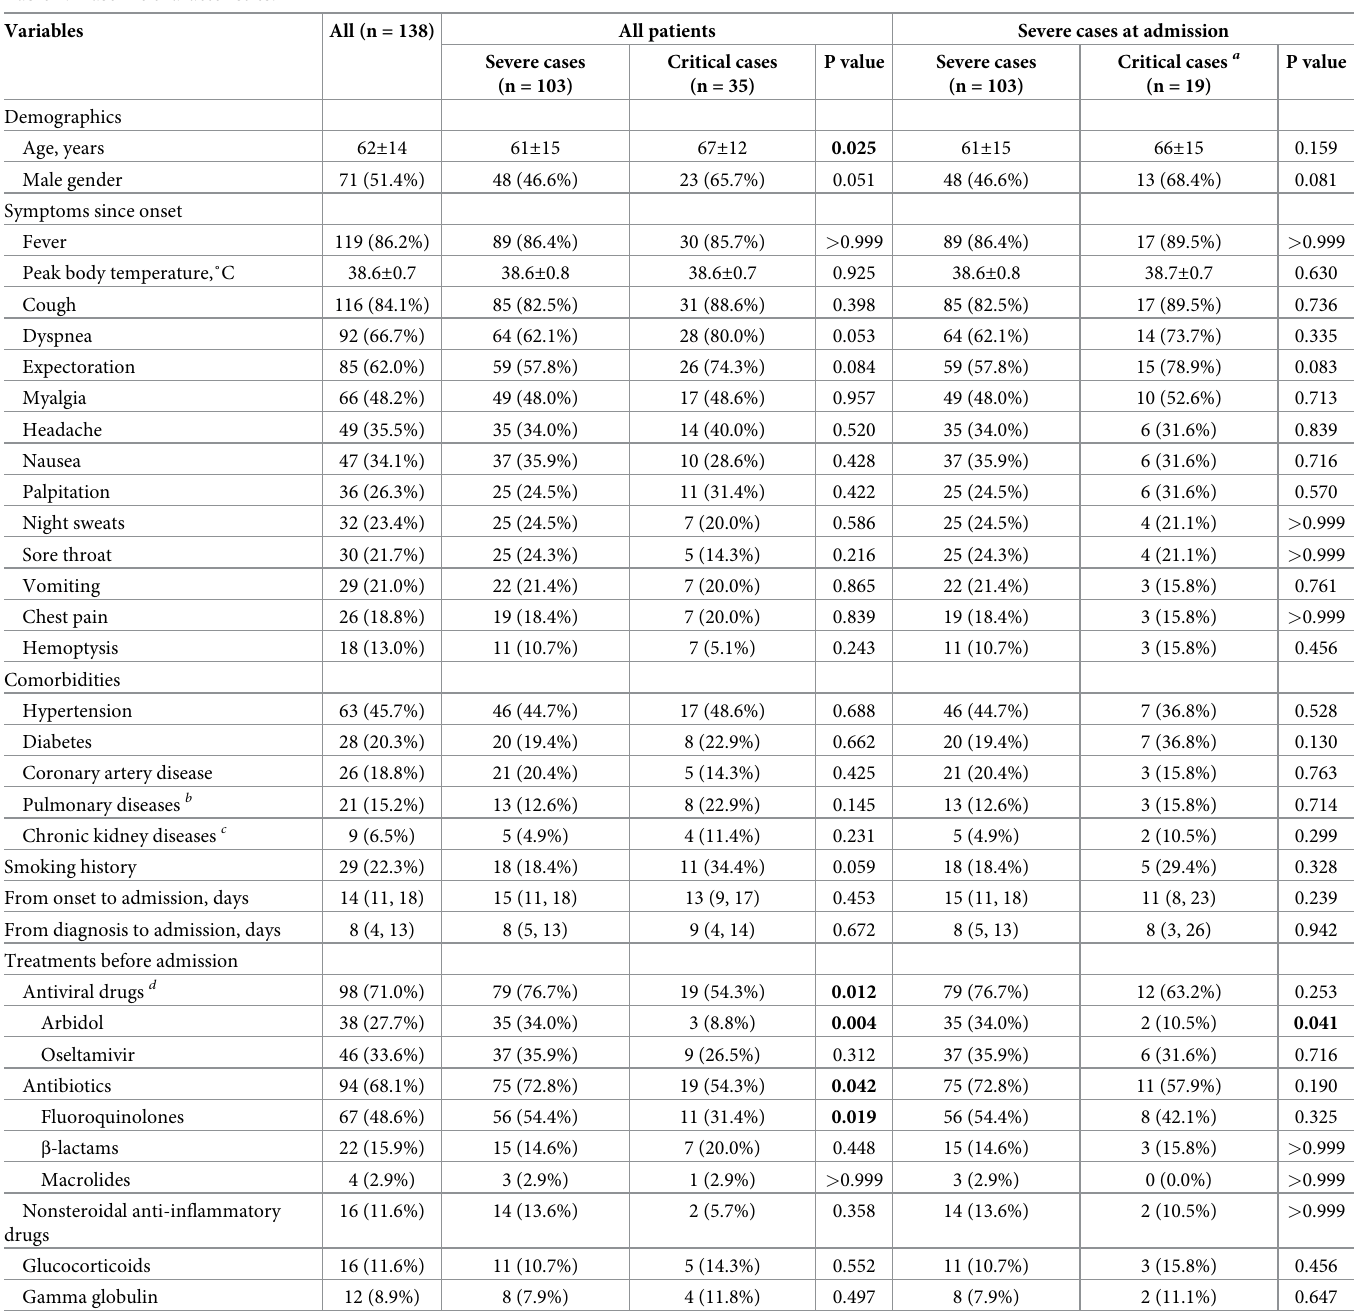
Table 1. Baseline